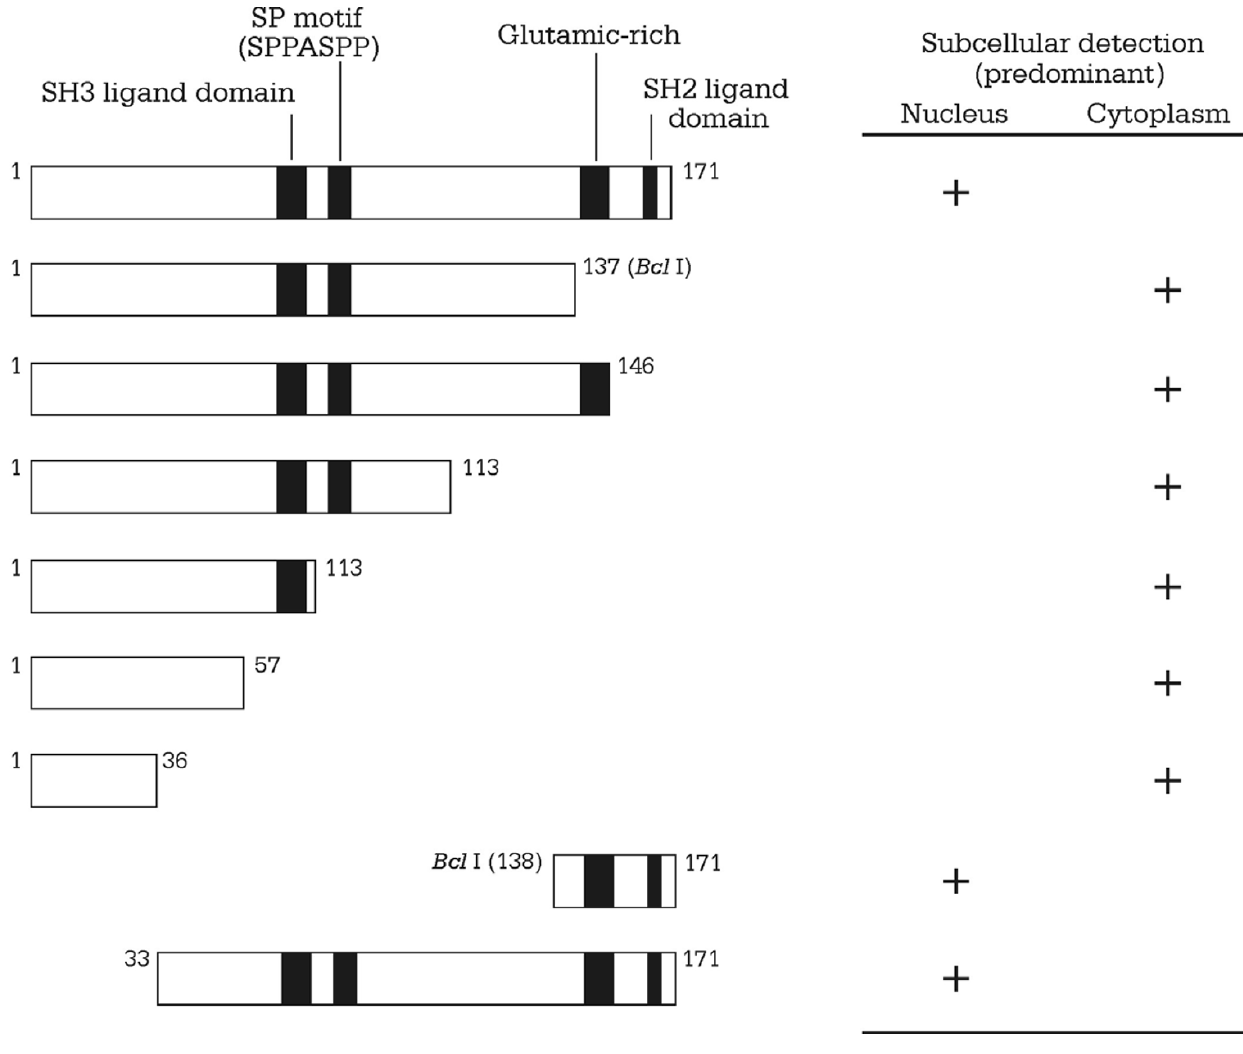
Figure 1 Schematic DSCR1 truncation protein series (left) and subcellular location (right) Predicted domains indicated in the diagram have been previously described [4]. Description of the different constructions is given in the material and